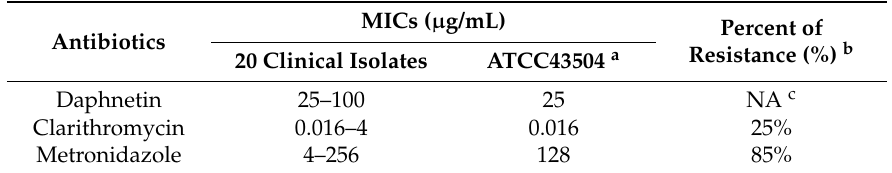
Table 1. Minimum inhibitory concentrations (MICs) of daphnetin, metronidazole, and clarithromycin against H. pylori strains.